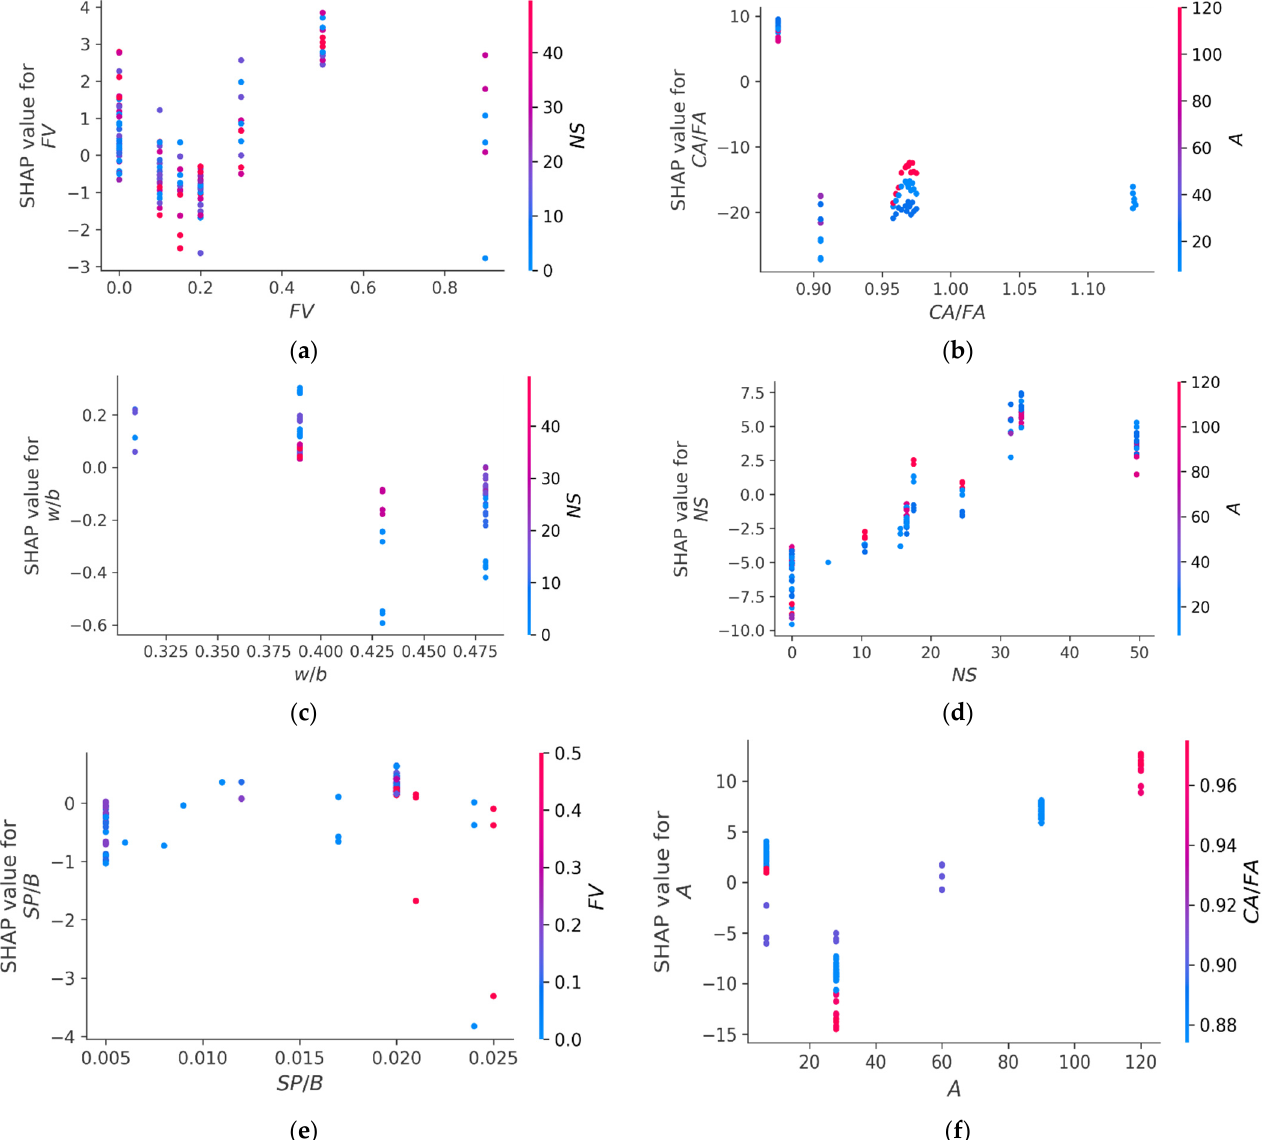
Figure 16. Interaction graphs: ( a ) Fiber volume; ( b ) Coarse aggregate to fine aggregate ratio; ( c ) water to binder ratio; ( d ) Nano-silica; ( e ) Superplasticizer to binder ratio ( f ) Age of specimen.